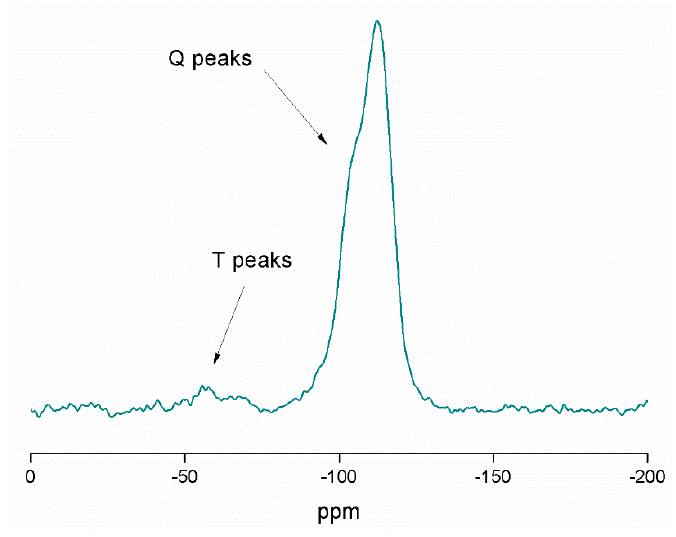
Figure 3. 29 Si MAS NMR spectrum of MSN-AP-FA-PEP-S-Sn.